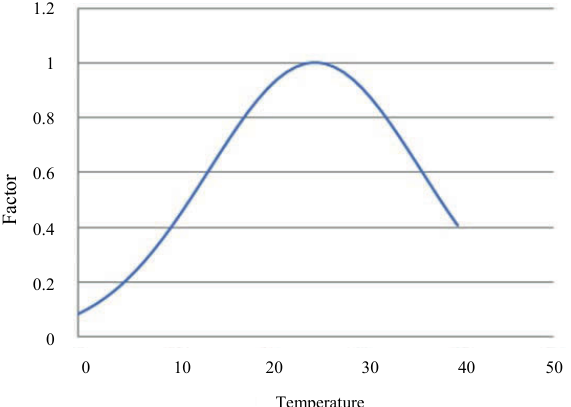
Fig. 3. Temperature factor for non-optimal temperatures